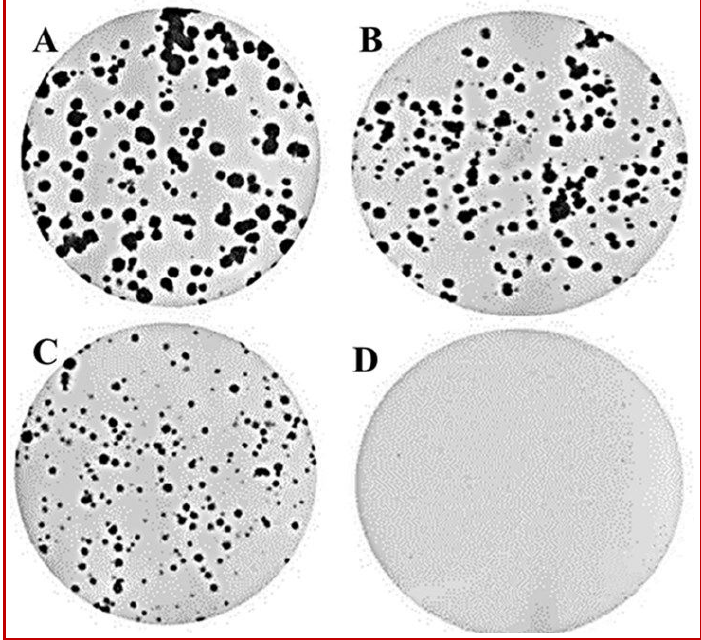
Figure 2: Inhibition of colony formation in HeLa cervical cancer cells induced by syringin. The cells were treated with 0 (A), 10 (B), 50 (C) and 100 µM (D) of syringin and the number of colonies were counted by light microscope